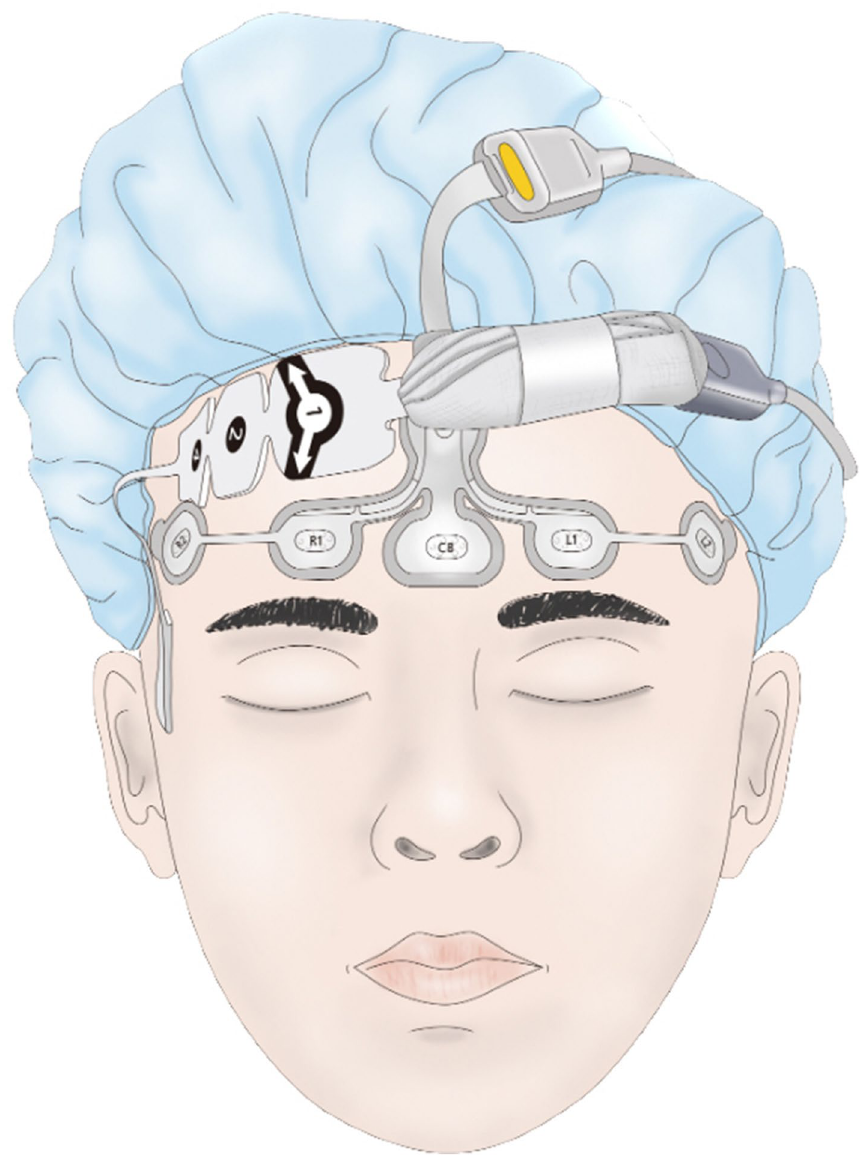
Figure 1. Attachment of Bispectral Index and Patient State Index sensors on a patient’s